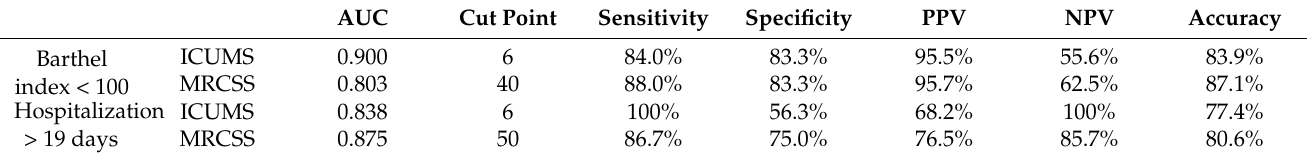
Figure 3. The ROC curve of ICUMS and MRCSS in predicting those hospitalized more than 19 days. Table 6. The AUC, cutoff points, sensitivity, specificity, PPV, NPV, and accuracy of ICUMS and MRCSS to predict patients with Barthel index < 100 at three months after discharge and hospitalization > 19 days.